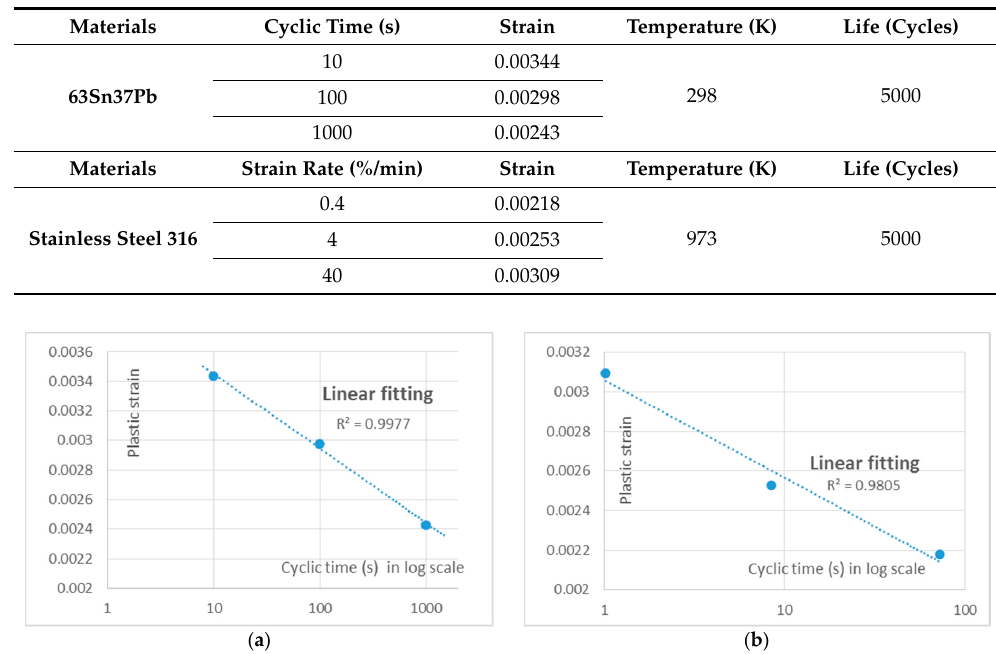
Figure 5. Curve fitting of log of cyclic time vs. strain for experimental data: ( a ) 63Sn37Pb; ( b ) stainless steel 316. Raw data from [21,51] respectively.